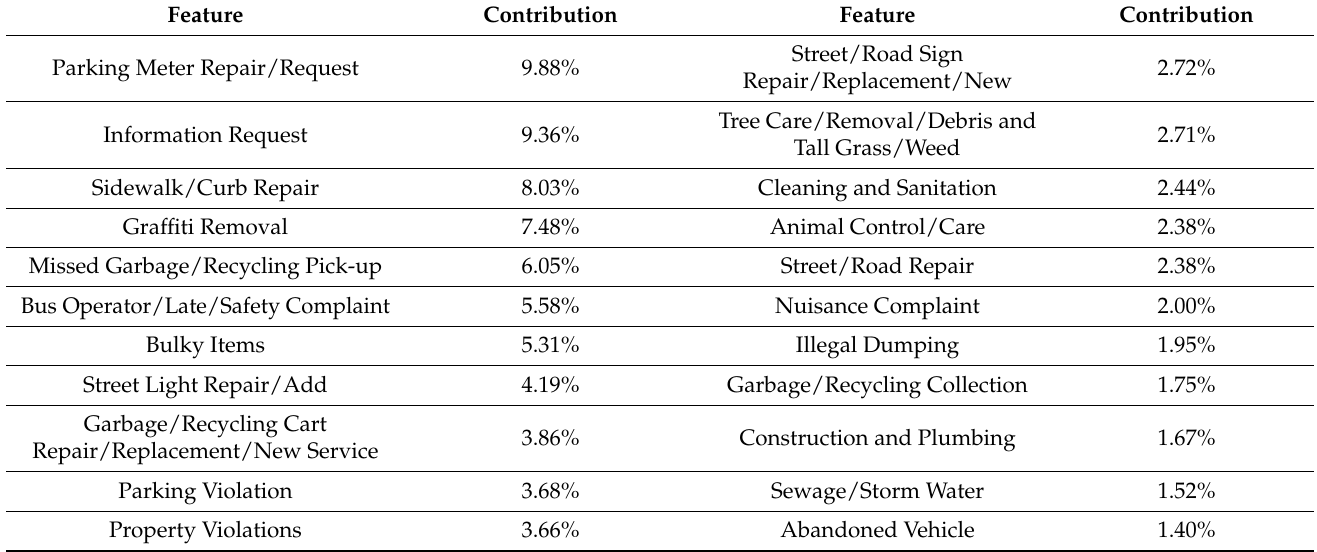
Table 3. Features with more than 1% contribution in the PCA